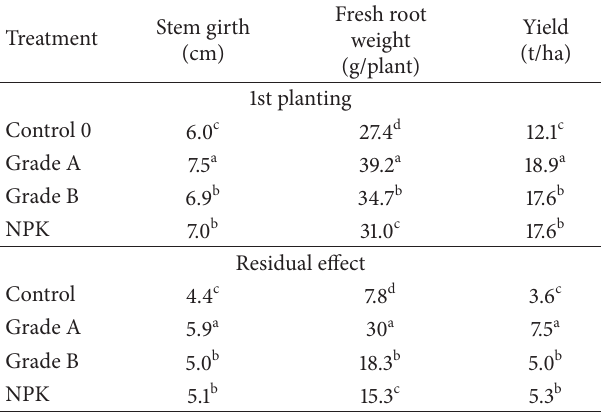
Table 3: Effect of fertilizer types on the stem girth and yield param- eters of Amaranthus caudatus at 4 weeks after